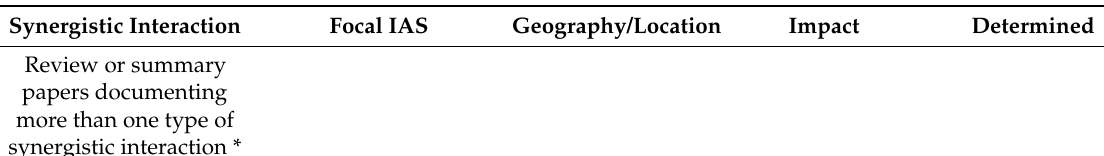
Table 2. Examples summarizing key aspects of the synergistic interaction between climate change and invasive alien species (IAS) forming part of the positive feedback loop between climate change, IAS, and native biodiversity loss. “Focal IAS” describes the invasive taxa examined. “Geography/Location” refers to the geographic focus or location of the study. “Impact” describes the outcome of the interaction, such that “Exacerbates” indicates the outcome benefits IAS or exacerbates climate change and “Reduces” indicates the outcome is detrimental to IAS or mitigates climate change. “Determined” indicates if the outcome was predicted and/or observed. The table is not